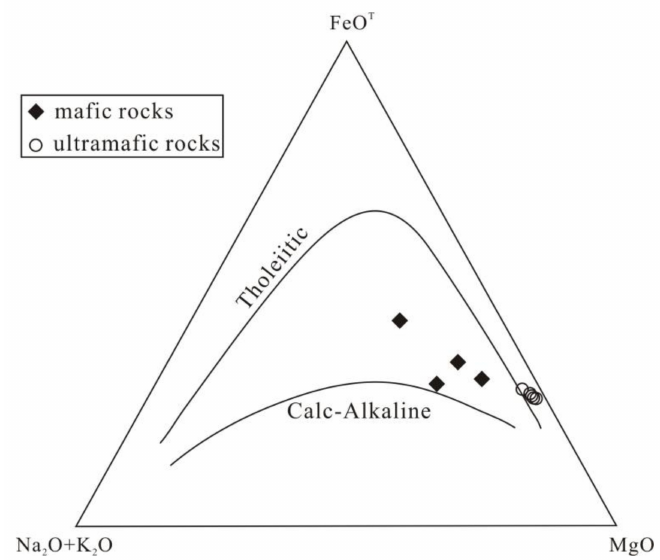
Figure 9. AFM diagram for the mafic-ultramafic rocks of the Baixintan intrusion (after [92]). In a plot of Ni/Cu (1.91–15.01) and Pd/Ir (6.56–11.17) ratios, the majority of the